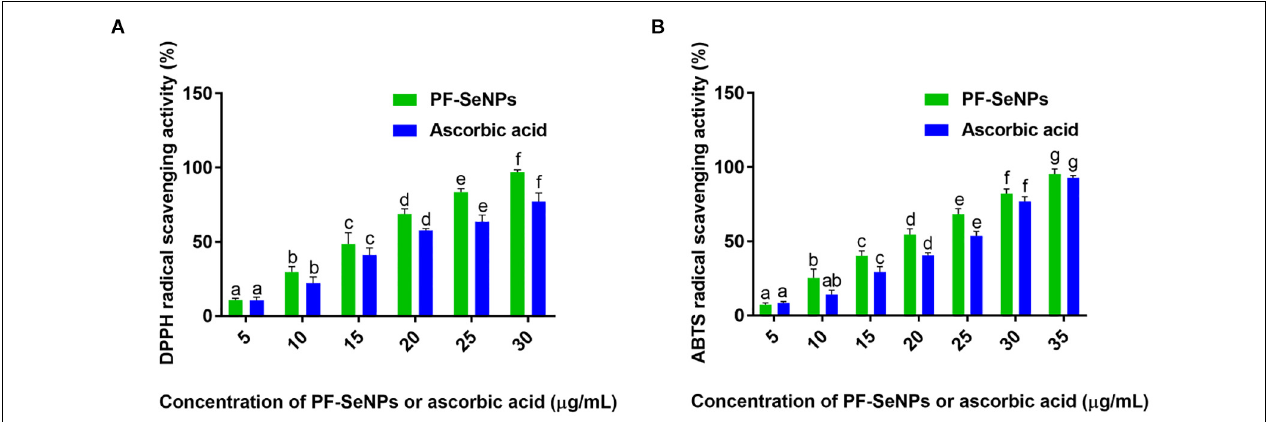
FIGURE 7 | Determination of dose-dependent antioxidant potential of phytofabricated selenium nanoparticles (PF-SeNPs) and ascorbic acid by (A) DPPH and (B) ABTS radical scavenging assays. The experiment was executed independently in triplicates and data was expressed as mean ± SD. The statistical difference between the test samples were assessed by Tukey’s multiple comparison test and p ≤ 0.05 was considered as a significant. The bar graphs with different alphabetic letters within the respective study were significant.